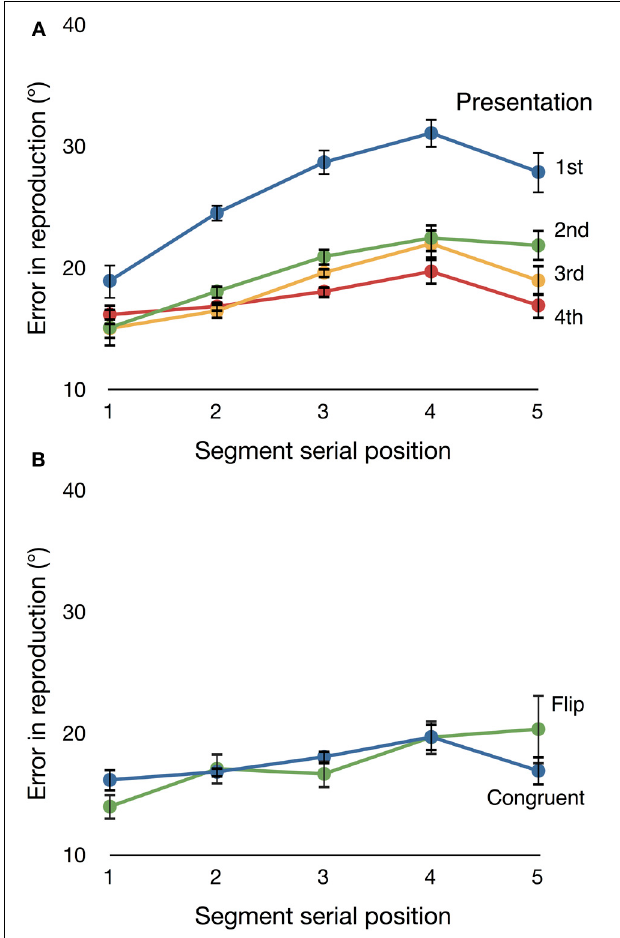
FIGURE 3 | (A) Mean directional error on Congruent trials across the five segments in a motion sequence. Data are displayed separately for each of the four presentations of a sequence. Subjects’ accuracy improved over repeated presentations. (B) Mean directional error on Flip and Congruent trials for the fourth (final) presentation. The two conditions do not differ significantly. Error bars are repeated-measures standard error (Morey,